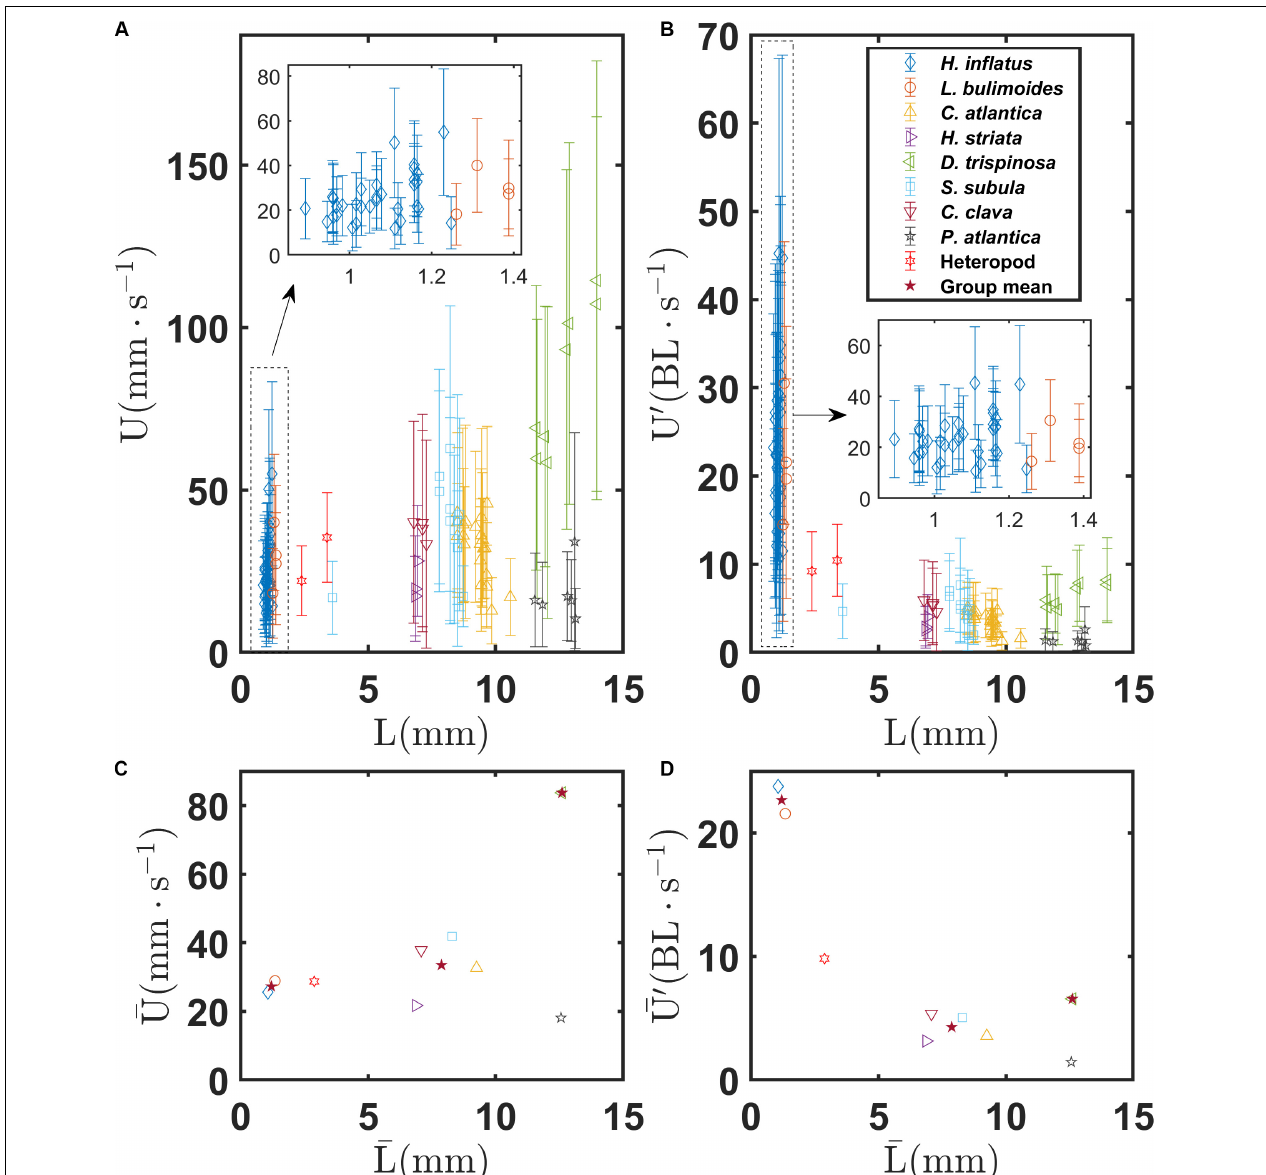
FIGURE 6 | (A) Mean and standard deviation of swimming speed U of individual marine snails as a function of body length L for various marine snail species. (B) Normalized mean and standard deviation of swimming speed U (cid:48) of individual marine snails as a function of body length L for various marine snail species. (C) Mean swimming speed ¯ U of various marine snail species as a function of mean body length ¯ L . (D) Mean swimming speed ¯ U (cid:48) of various marine snail species as a function of mean body length ¯ L . Stars in (C,D) indicate group means of coiled, elongated, and globular shelled thecosome species.